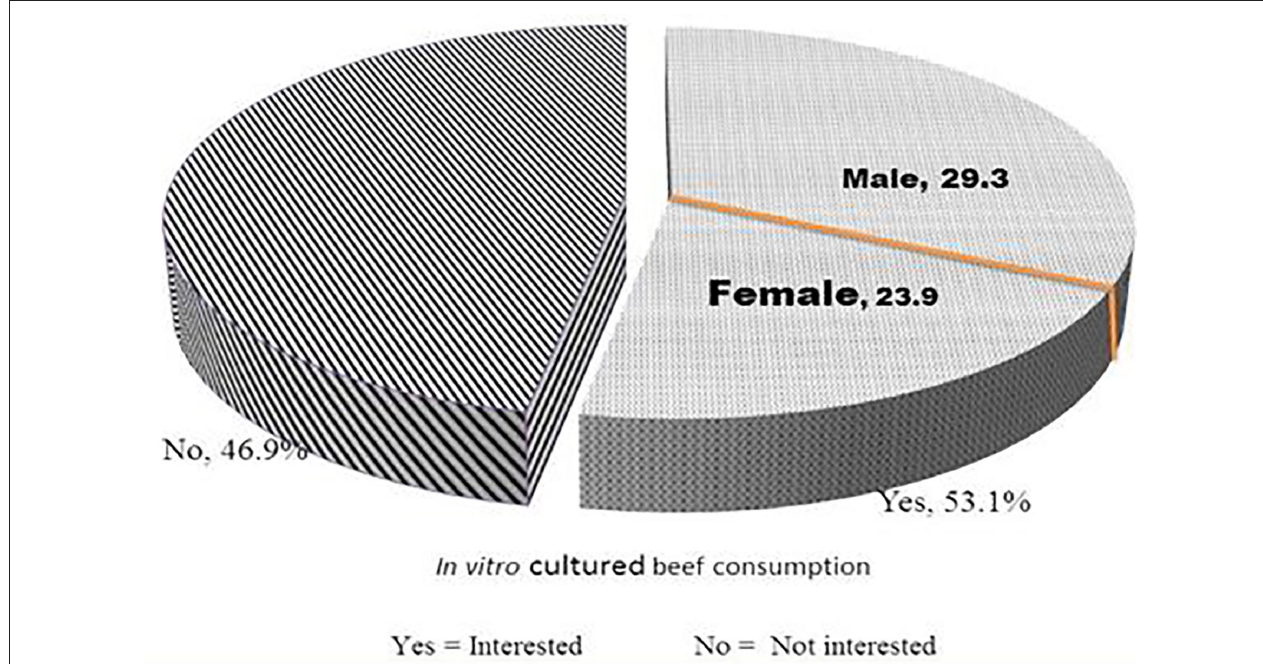
FIGURE 3 | Consumers interest in the consumption of cultured beef in Eastern Cape Province of South Africa.